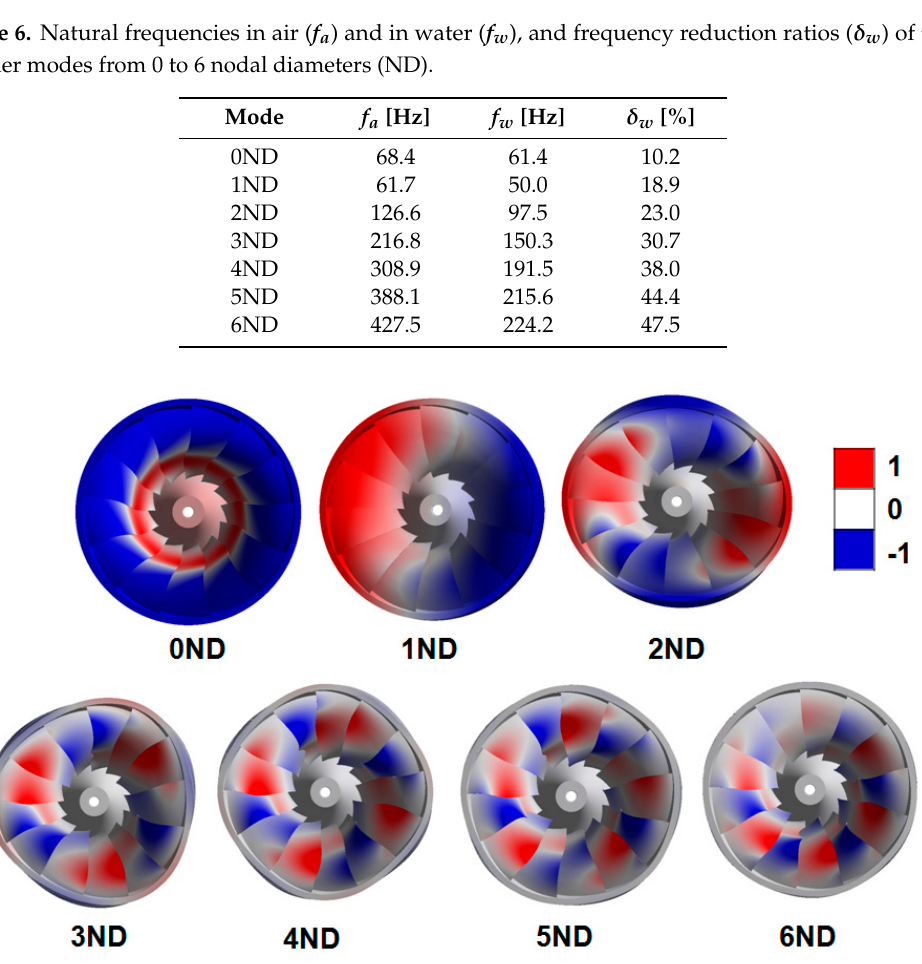
Figure 12. Bottom view of the Francis runner mode shapes in air with normalized deformations.